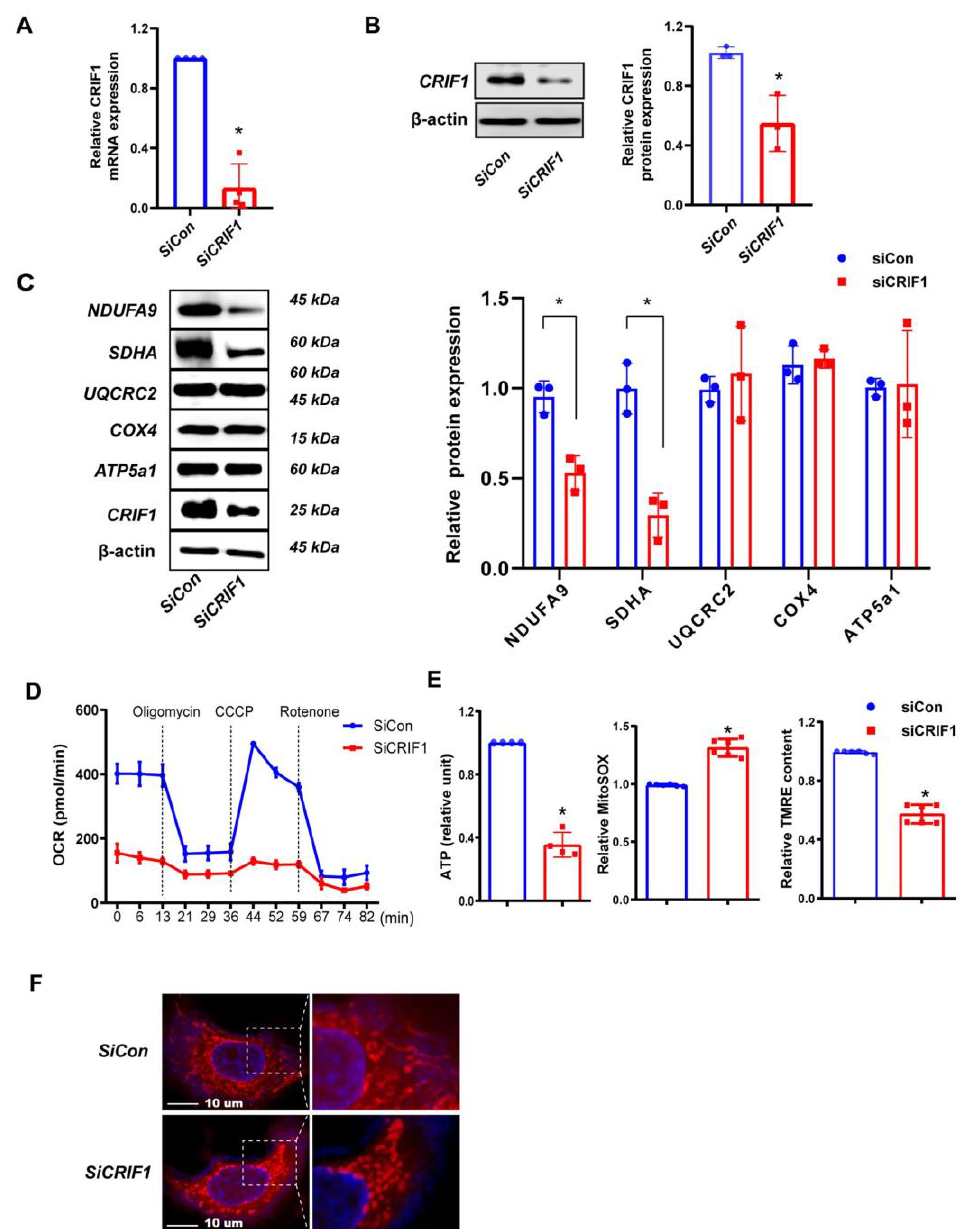
Figure 1. CRIF1 deficiency disturbed mitochondrial OXPHOS and induced mitochondrial dysfunction in MCF-7 cells. MCF-7 cells were transfected with 100 pmol of siCon and siCRIF1 for 48 h. ( A ) CRIF1 mRNA levels was determined by qPCR. ( B ) CRIF1 protein levels and ( C ) mitochondrial OXPHOS complex subunits were detected by immunoblotting and then quantified by densitometric analysis. ( D ) OCR was analyzed by a Seahorse XF-24 flux analyzer. ( E ) Relative ATP levels, MitoSOX, and TMRE were measured by using a colorimetric/fluorometric assay kit. ( F ) Representative staining images of Mitotracker-red and DAPI. High-magnification images from the selected area are shown in the right. Scale: 10 μm. All data are presented as means ± SEM of at least three independent experiments. * p < 0.05 compared with siCon group.